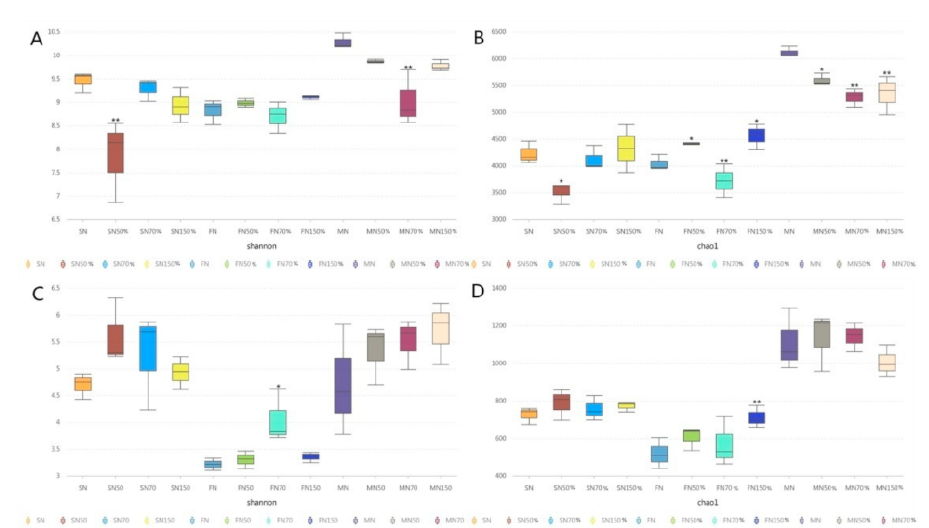
Figure 2. Alpha diversity index analysis of rhizosphere soil bacteria and fungi. ( A , B ) represent Scheme 1 index of bacteria; ( C , D ) represent Shannon index and Chao1 index; * and ** indicate significant differences at the 0.05 and 0.01 levels,